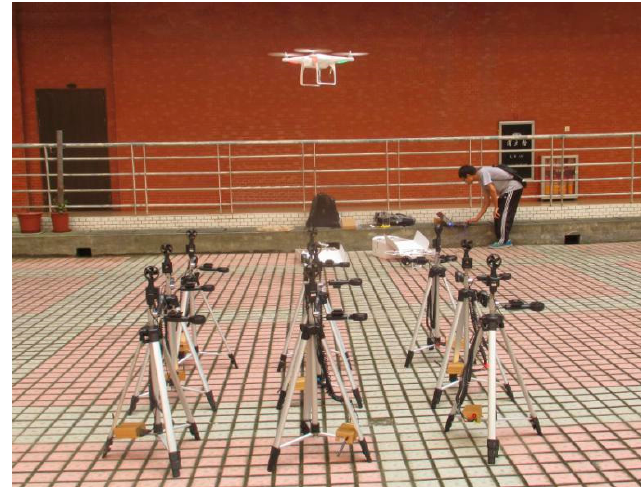
Figure 6. Actual test of downwash flow field.